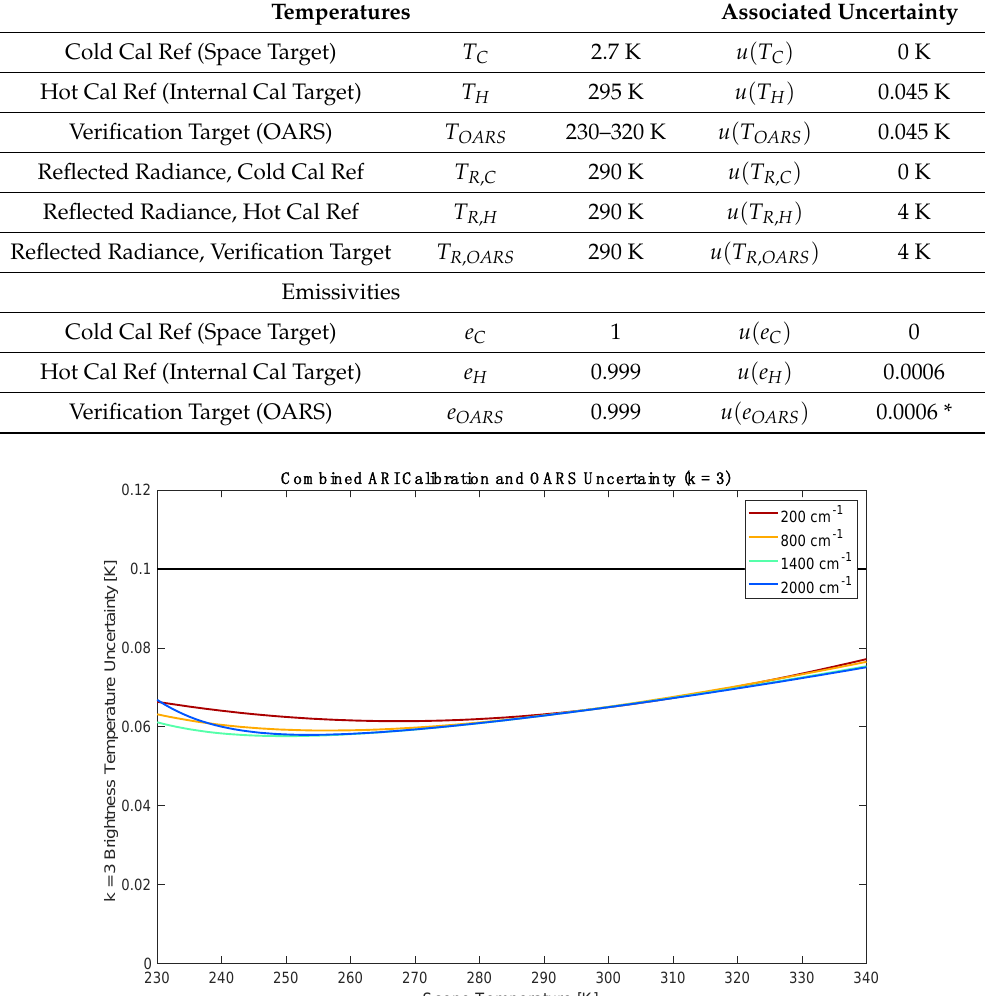
Figure 6. Predicted on-orbit combined radiometric calibration and verification uncertainty (k = 3).